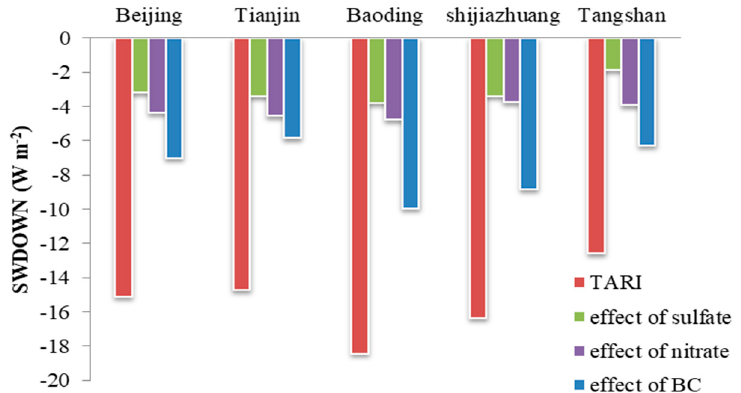
Figure 5. Simulated results of the ARI on SWDOWN. (ARI: aerosol-radiation interaction; SWDOWN: downward shortwave radiation).